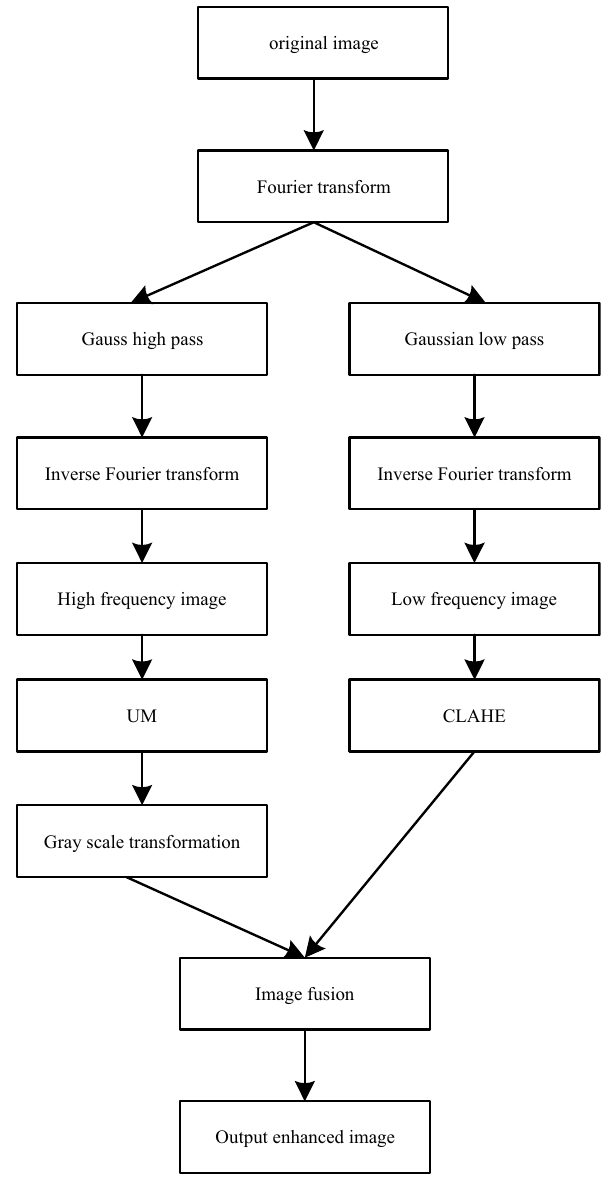
Figure 4: Image high - frequency and low - frequency separation